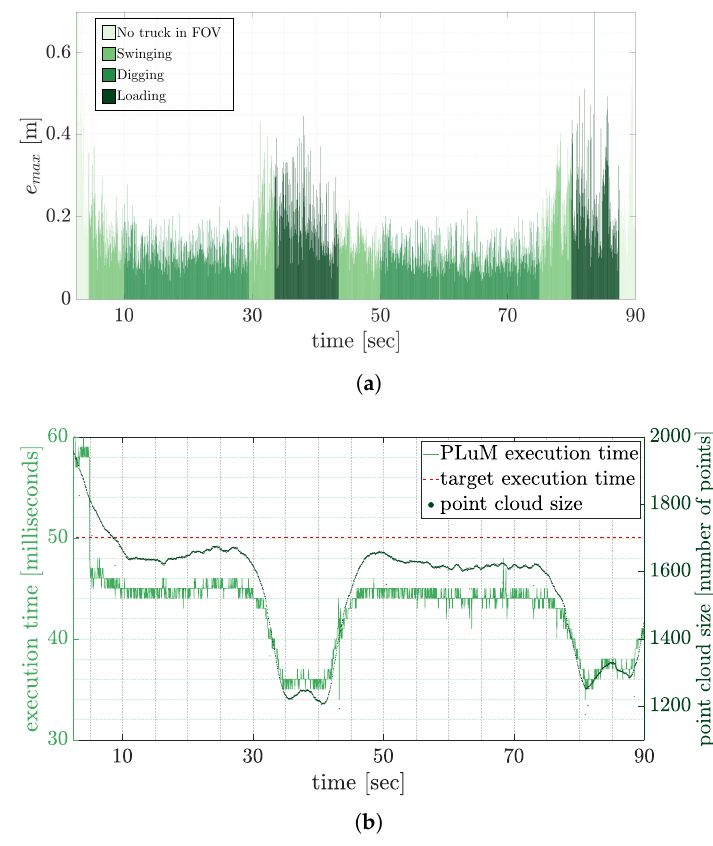
Figure 19. The PLuM truck pose estimation results using point cloud data subsampled using a factor of 20, i.e., the original point cloud reduces from 40,000 to 2000 measurements. The maximum vertex error for a 90 s loading cycle is reported in ( a ), and the corresponding execution time for each pose estimate is displayed in ( b